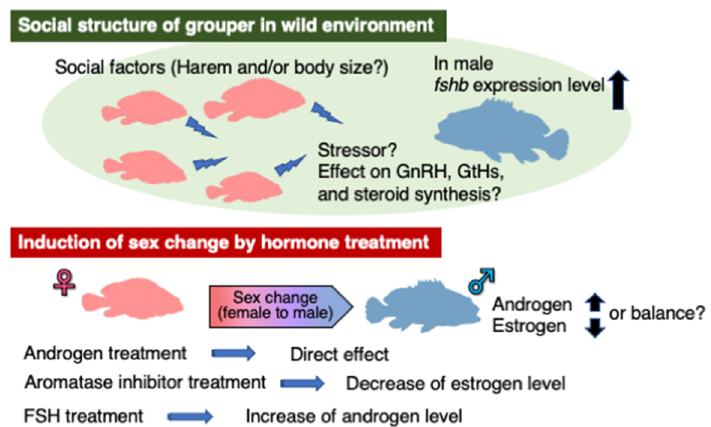
Figure 3. Factors involved in the induction of sex change in